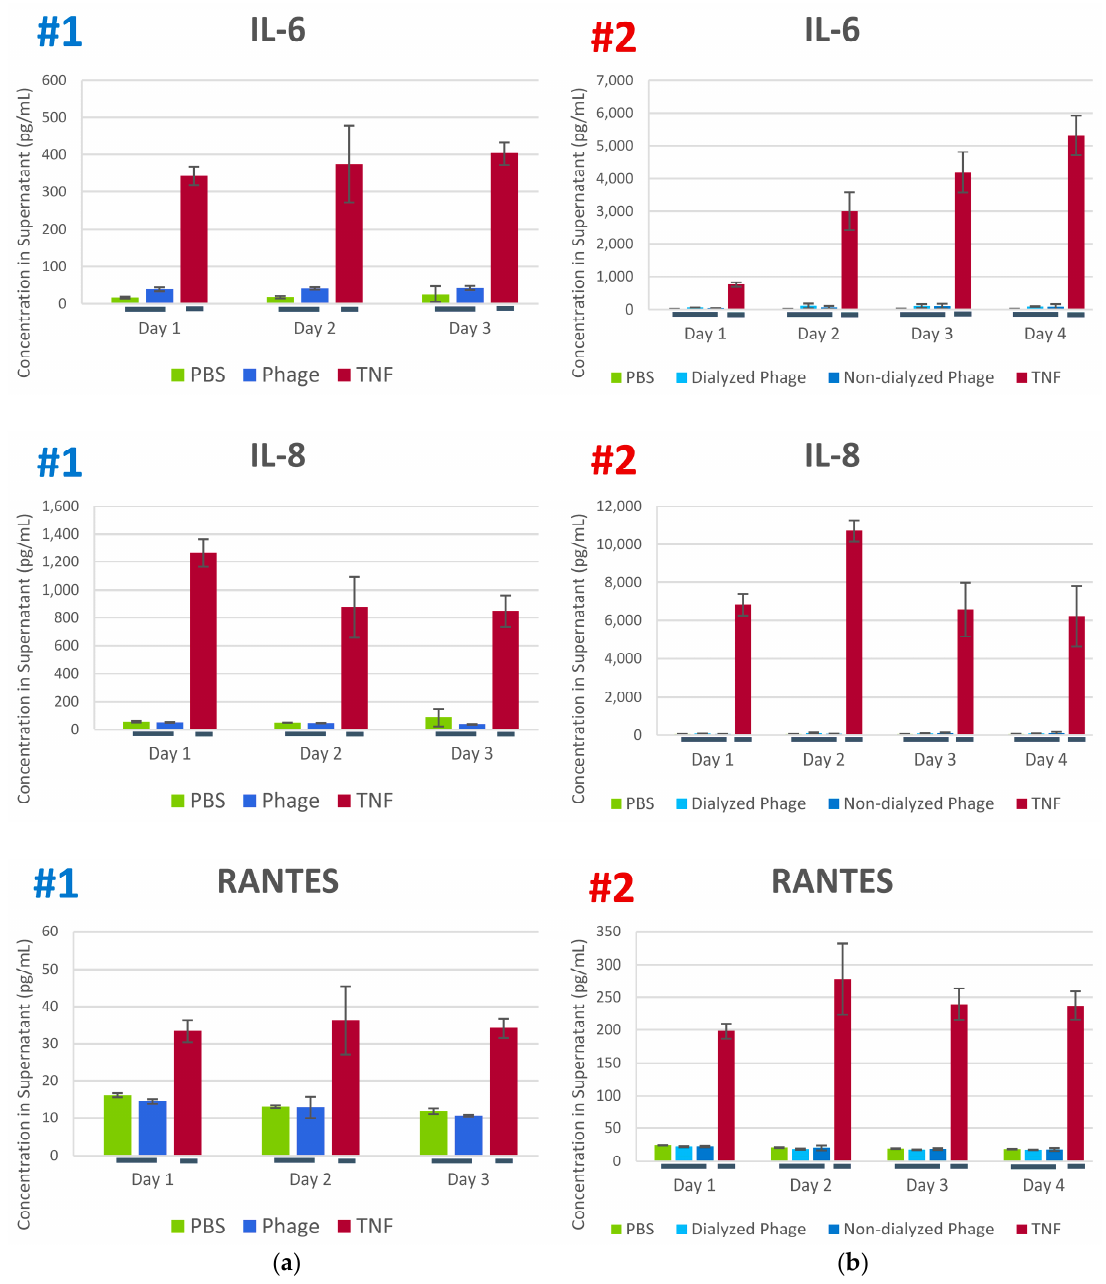
Figure 1. Examples of expression of cytokines IL-6, IL-8 and RANTES in response to phage K, PBS (negative control) and TNF (positive control) in experiments #1 ( a ) and #2 ( b ). Tukey grouping indicated by lines under bar graphs. p values can be found in Supplemental Tables.